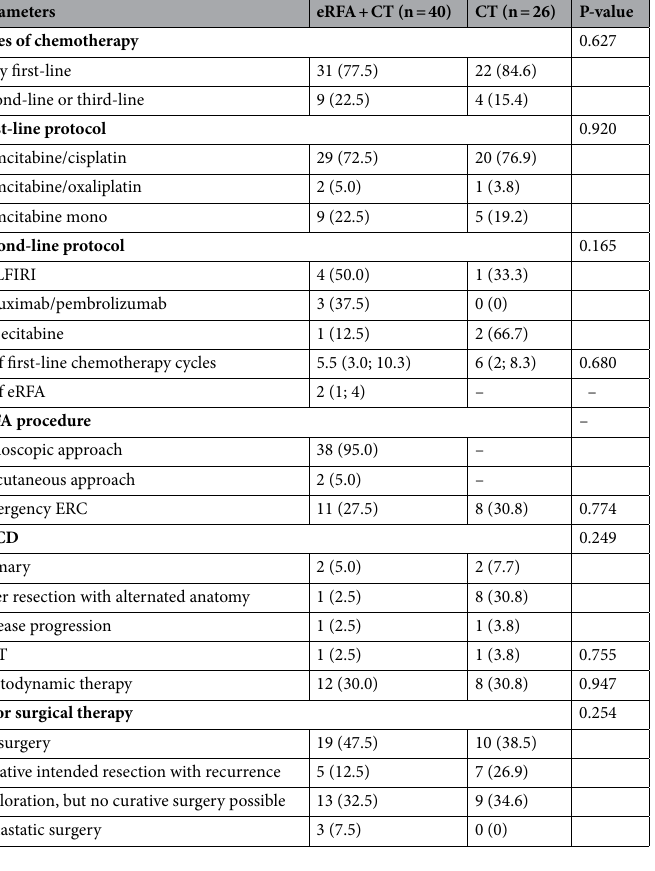
Table 2. Therapy characteristics. Categorical data are presented as absolute frequency with relative frequency in parentheses. Numerical data are presented as median with under and upper quartile in parentheses. ERC endoscopic retrograde cholangiography, eRFA endobiliary radiofrequency ablation, FOLFIRI chemotherapy regimen including folinic acid, fluorouracil and irinotecan, SIRT selective internal radiation therapy. P values of categorical data refer to Chi-squared test or Fisher exact test between groups eRFA + CT and CT. P values of numerical data refer to Student unpaired t test or Mann–Whitney test between groups eRFA + CT and